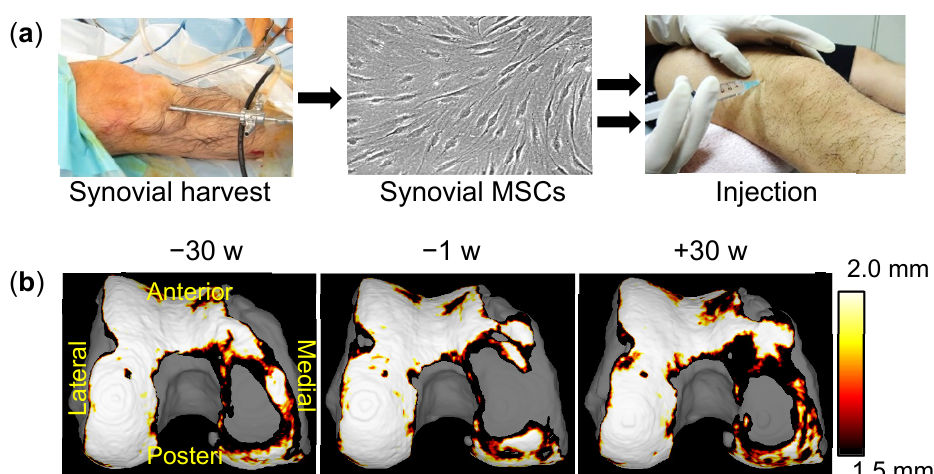
Figure 10. Clinical study of synovial MSC injections into OA knees. ( a ) Scheme of a clinical study of autologous synovial MSC injections into the OA knees of human patients. The synovium was harvested and enzymatically digested. The resulting synovial MSCs were expanded with autologous human serum and then injected into the knee twice at a 15-week interval. ( b ) Cartilage thickness mappings in a representative patient who underwent synovial MSC injections into a knee at time 0 and 15 weeks. MRI examinations were performed at − 30, − 1, and +30 weeks. Using the software we developed, the cartilage area was automatically extracted and visualized in three dimensions. Femoral cartilage at the posteromedial region at − 30 weeks had decreased at − 1 week but increased again at +30 weeks.